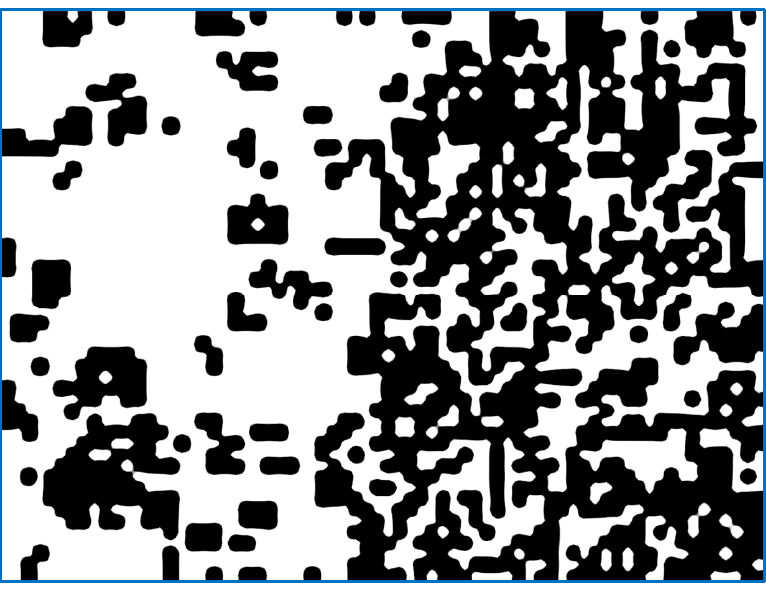
Figure 6. The asymmetry feature based on the brightness of a 64 × 64 fragment with 32 pixels step.